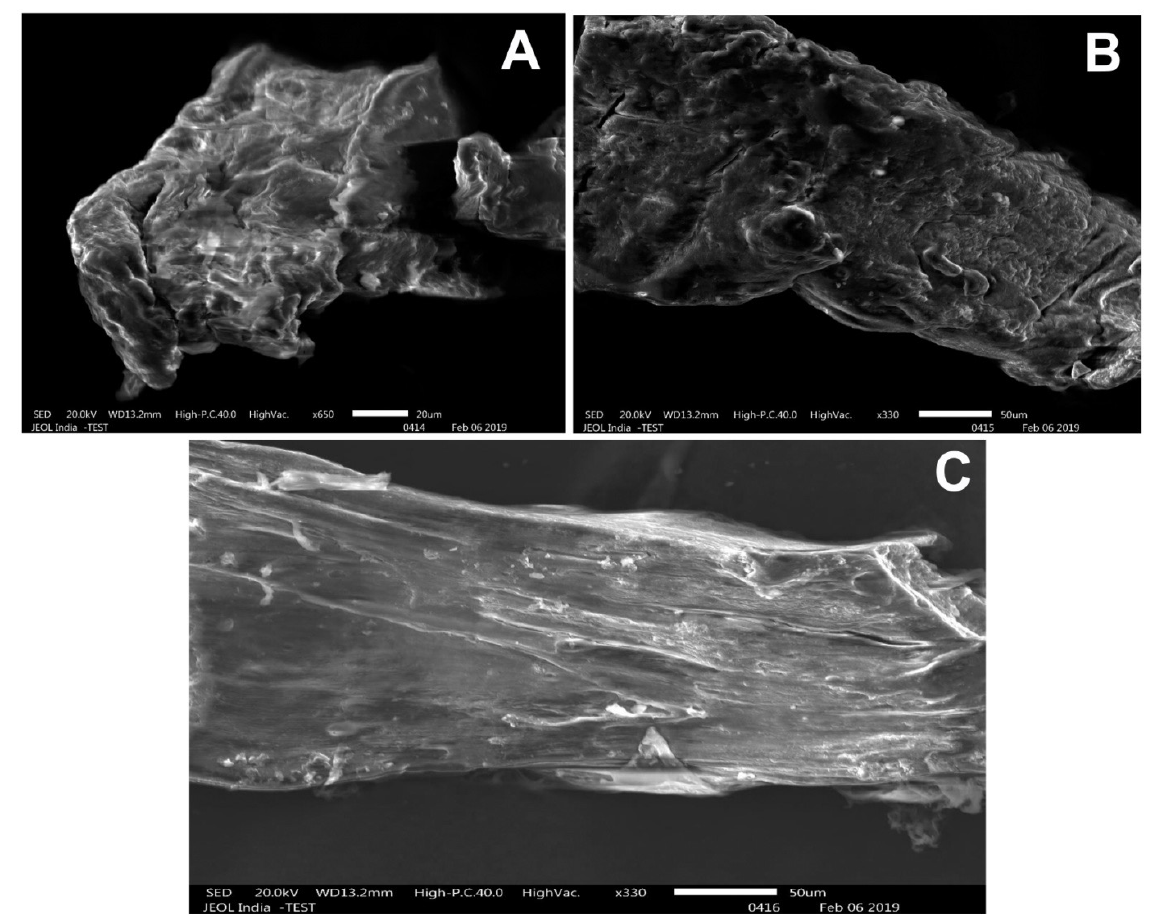
FIGURE 5 – SEM photomicrographs (A) irregular shape microparticle, (B) uniform distribution of polymer matrix and (C) internal morphology of